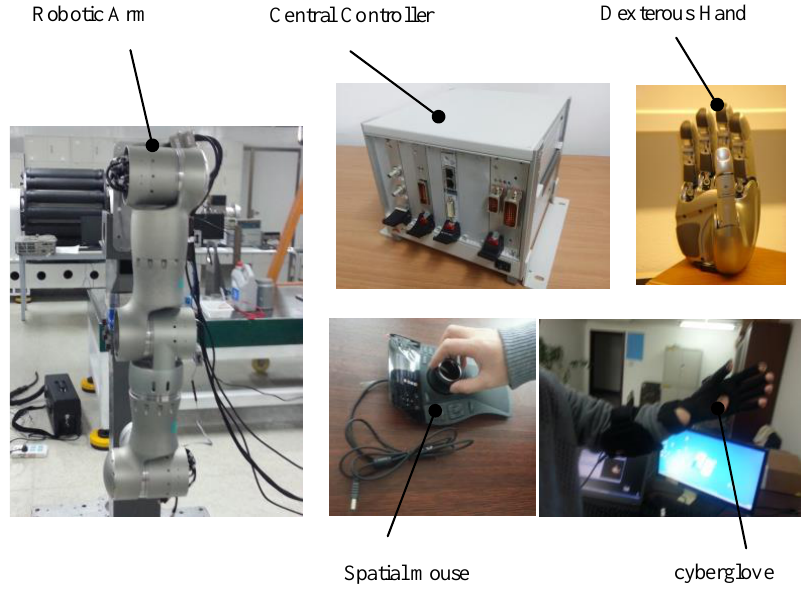
Figure 4. Prototype of space manipulator